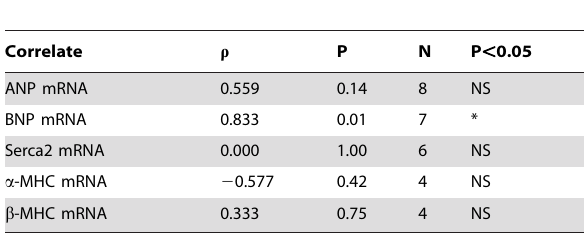
Spearman correlation coefficients; r = correlation coefficient, P=p value, N= #